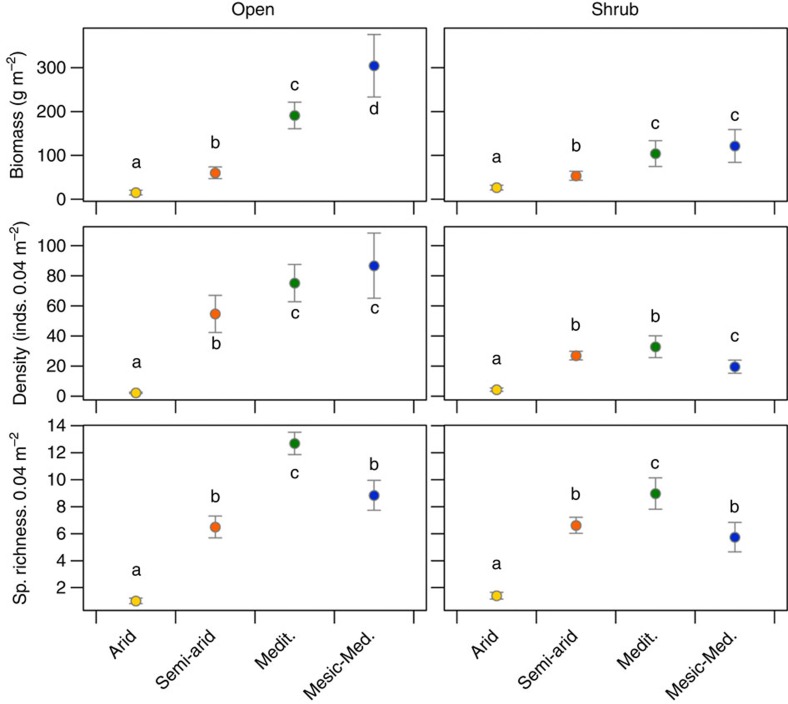
Mean above-ground biomass, plant density and species richness (sp. richness) under ambient (control) conditions.Data stems from open areas and areas under shrubs in four sites (indicated by four different colours) along the rainfall gradient, calculated across all 10 study years. These patterns provided the predictions for the response to the rainfall manipulations in the two intermediate sites, based on the space-for-time assumption of bioclimatic envelope models (yet assuming in situ change instead of migration of plants). Mean values with different letters are significantly different from each other within each panel (LMM Tukey–Kramer adjusted contrasts P<0.05; N=105 (biomass); N=120 (density and richness)). Note that although displayed on normal scale, biomass and density were statistically analysed on a log scale. inds., individuals.